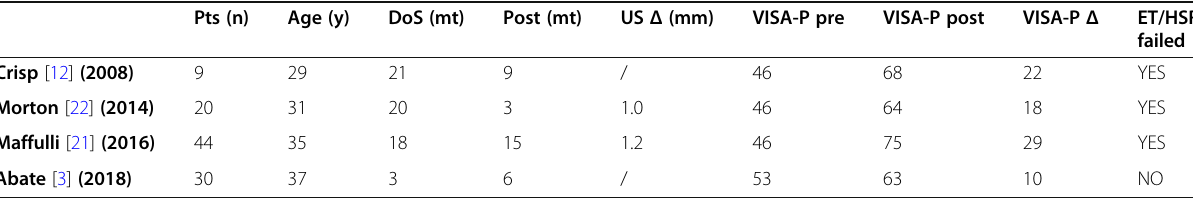
Table 3 Studies presenting data on High-volume Image-guided Injection (HVIGI) Pts (n) DoS